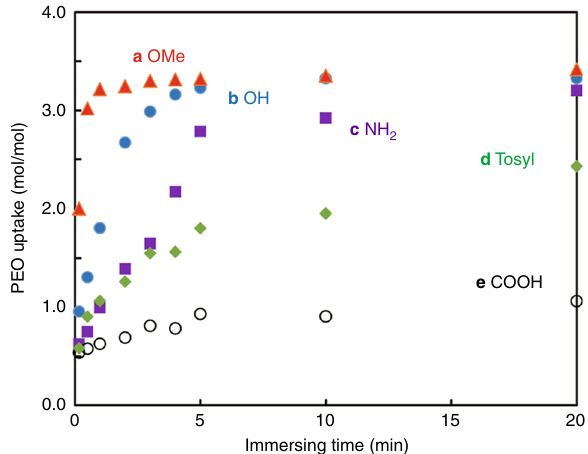
Fig. 4 Effect of end groups on PEO uptake. Uptake ratio of PEO with a , OMe (PEO1000-OMe), b OH (PEO1000-OH), c NH 2 (PEO1000-NH 2 ), d tosyl (PEO1000-Ts), and e COOH (PEO1000-COOH) end groups by activated